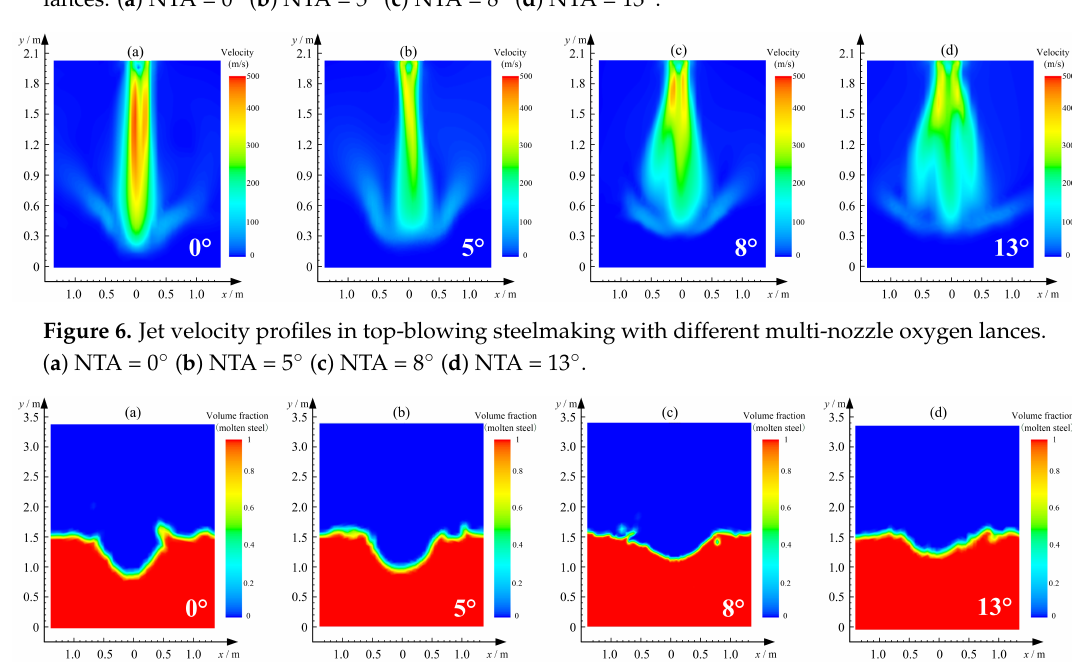
Figure 5. Dynamic pressure profiles in top-blowing steelmaking with different multi-nozzle oxygen